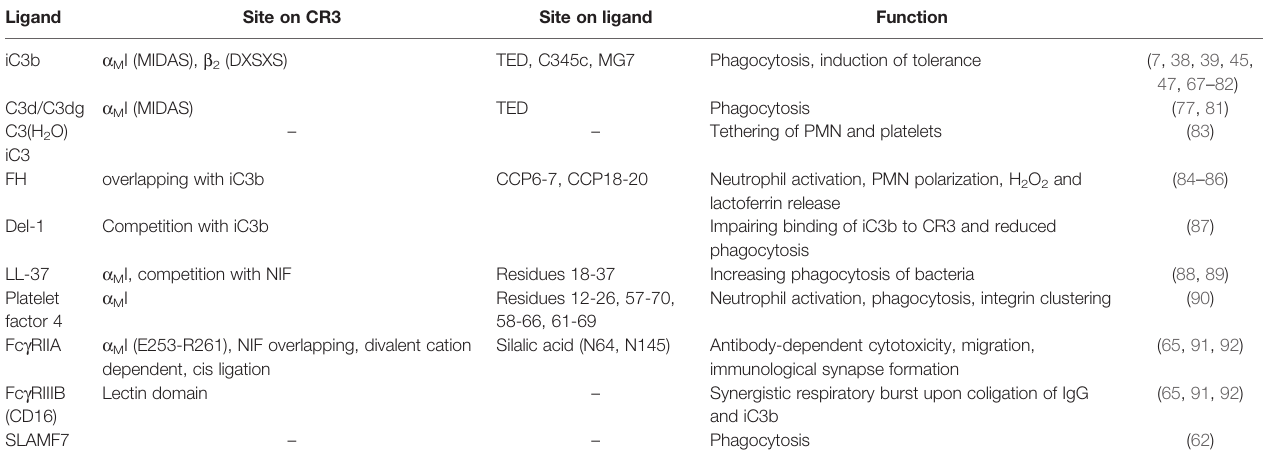
TABLE 1 | Host defense